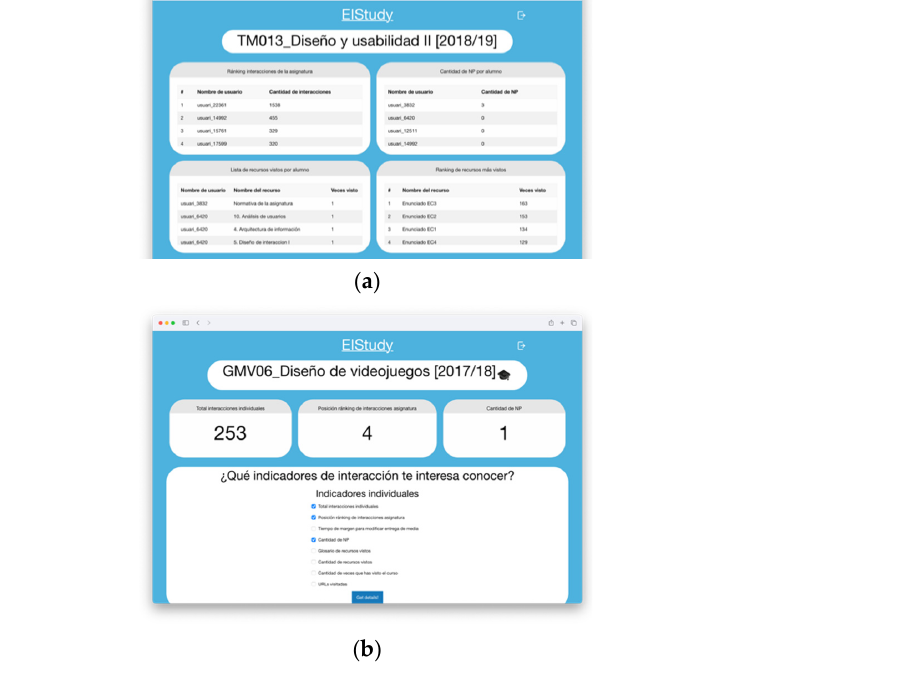
Commented [m4]: if the (a) image is not completed.